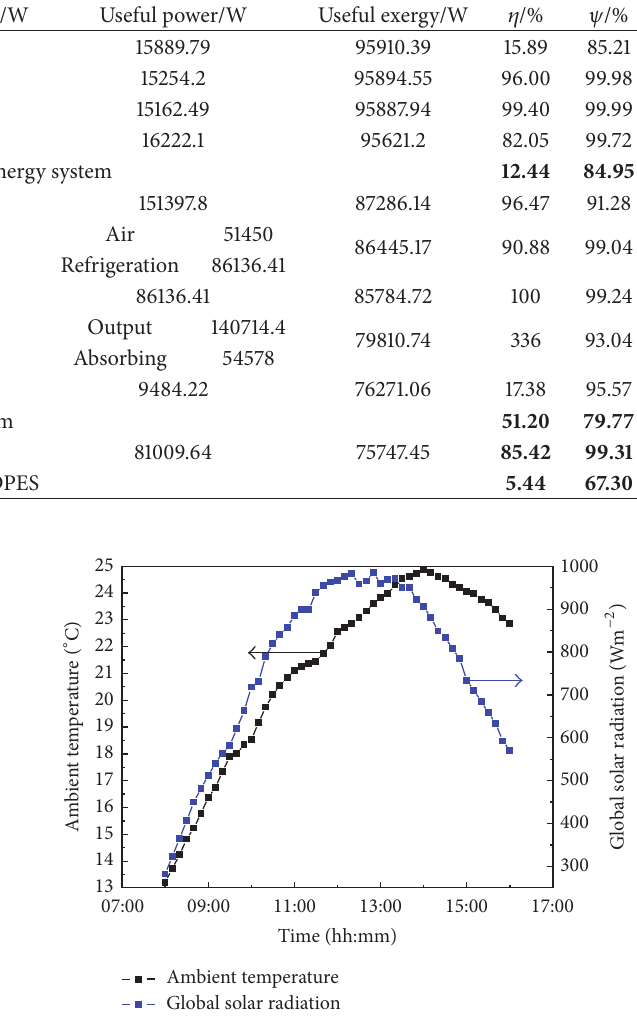
Figure 7: Variations of global solar radiation and ambient temper- ature on 22nd Nov., 2015, in